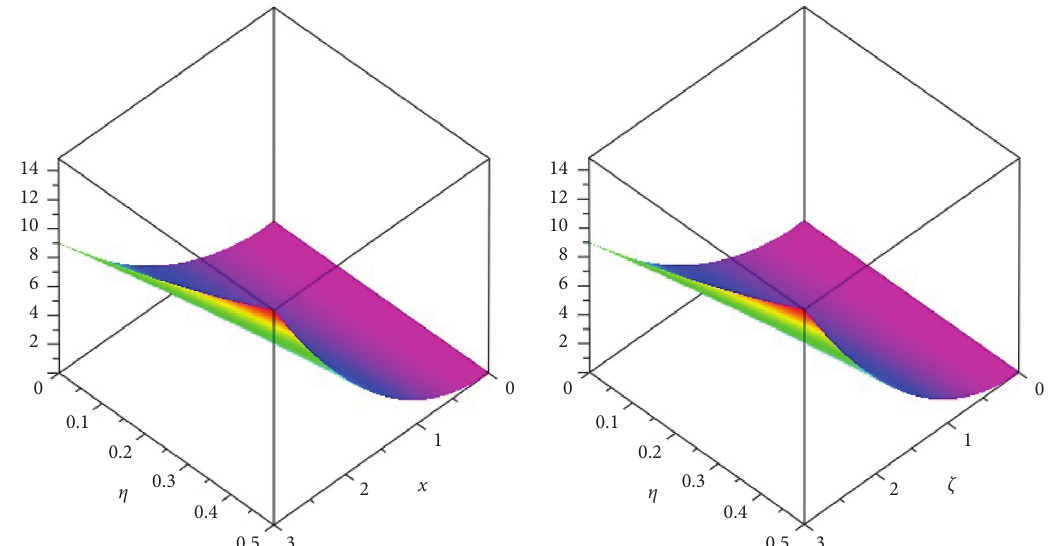
Figure 4: The approximate and exact result graph of problem 4.2, at δ � 1.